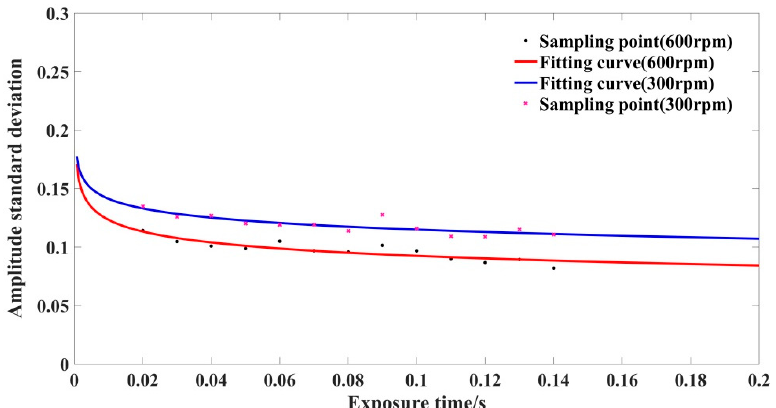
Figure 8. Comparison of fitted curves of amplitude standard deviation for 1500 grit diffusers at 300 rpm and 600 rpm in doubly scattered system. 300 rpm and 600 rpm in doubly scattered